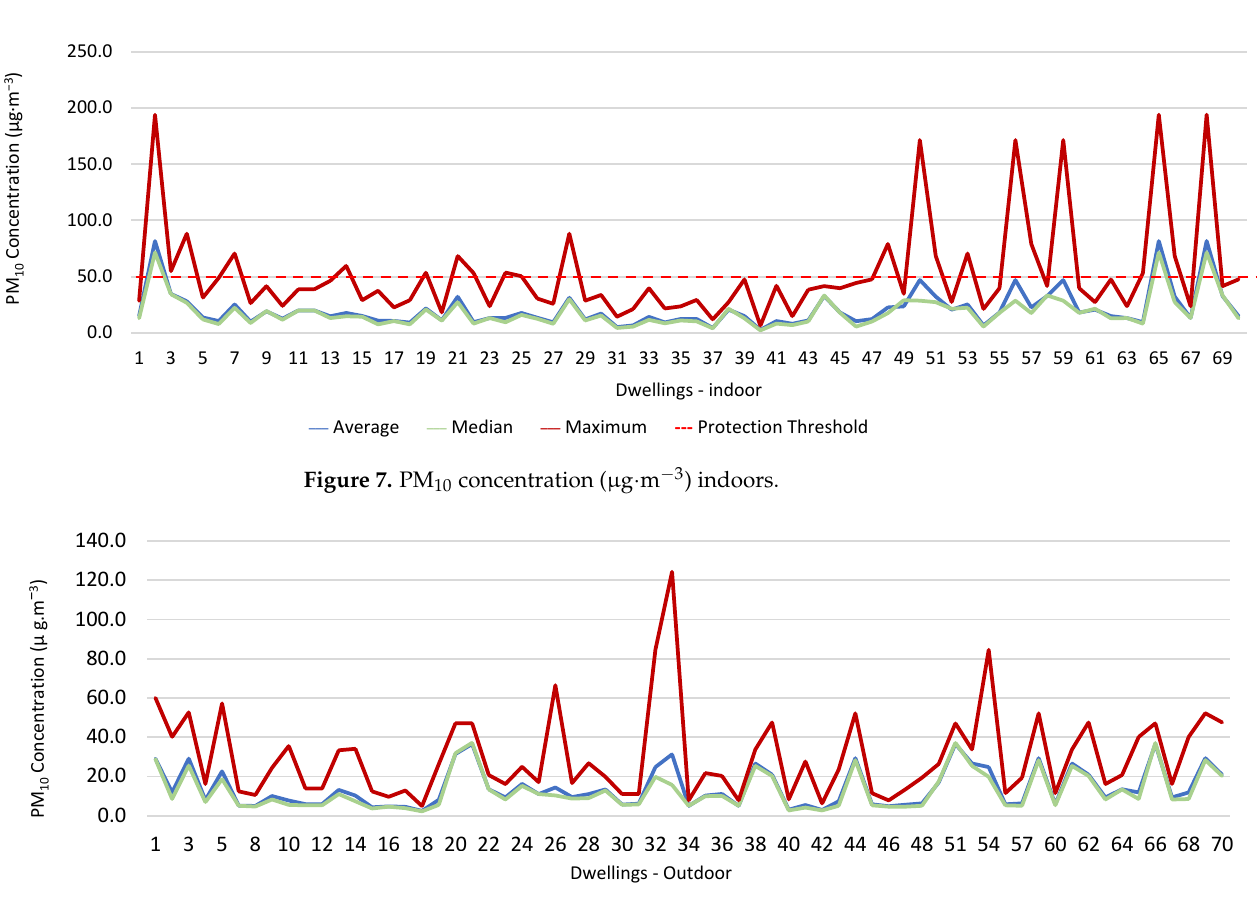
Figure 8. PM 10 concentration ( μ g·m − 3 ) outdoors.